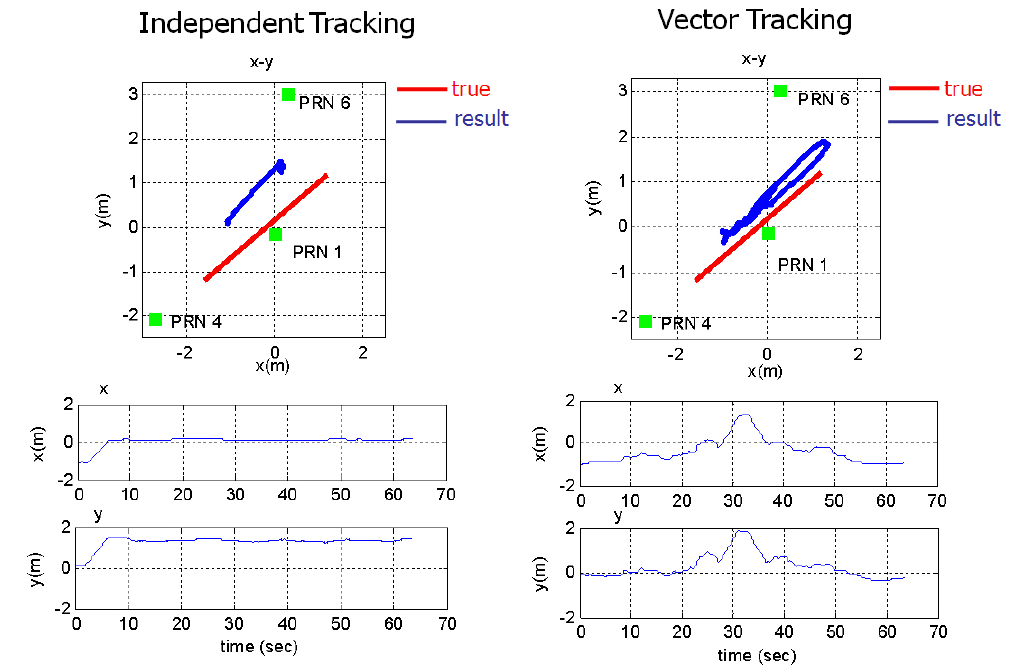
Figure 22. Navigation results: ITL (left) and VTL